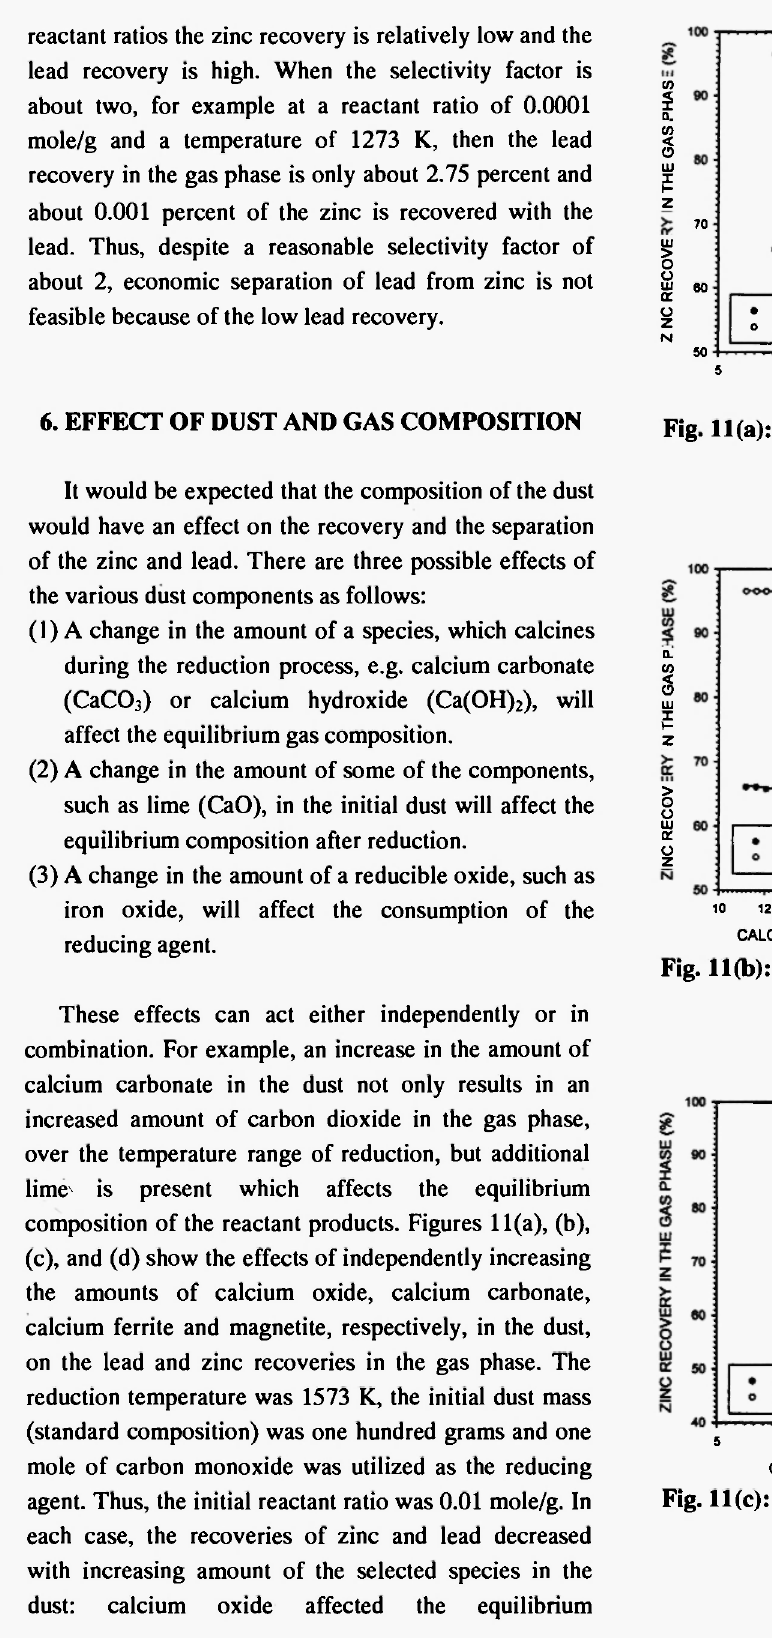
Fig. 11(b): Effect of the calcium carbonate content of the dust on the zinc and lead recoveries for an input of one mole of carbon monoxide at 1573 K.